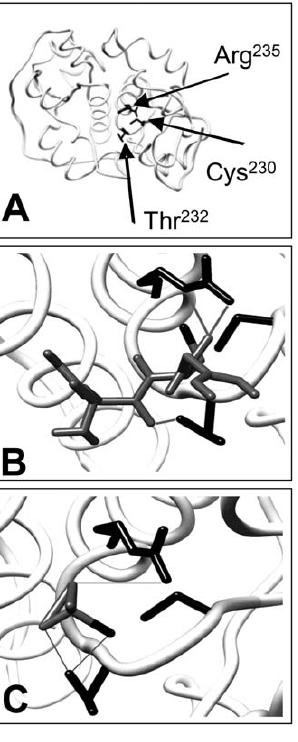
Figure 3 . In silico docking of glutathione and thiosulfate to RhdA. Overall RhdA structure ( A ) and its active site region interacting with either reduced glutathione ( B ) and thiosulfate ( C ). The amino acidic residues (Arg 235 , Thr 232 and Cys 230 ) involved in the interactions are highlighted in black. Ligand backbones are displayed as dark grey sticks. In silico computed hydrogen bonds between ligands and amino acidic residues are displayed as light grey solid lines. Images of molecular docking has been generated using UCSF chimera software (http://www.cgl.ucsf.edu/chimera/).